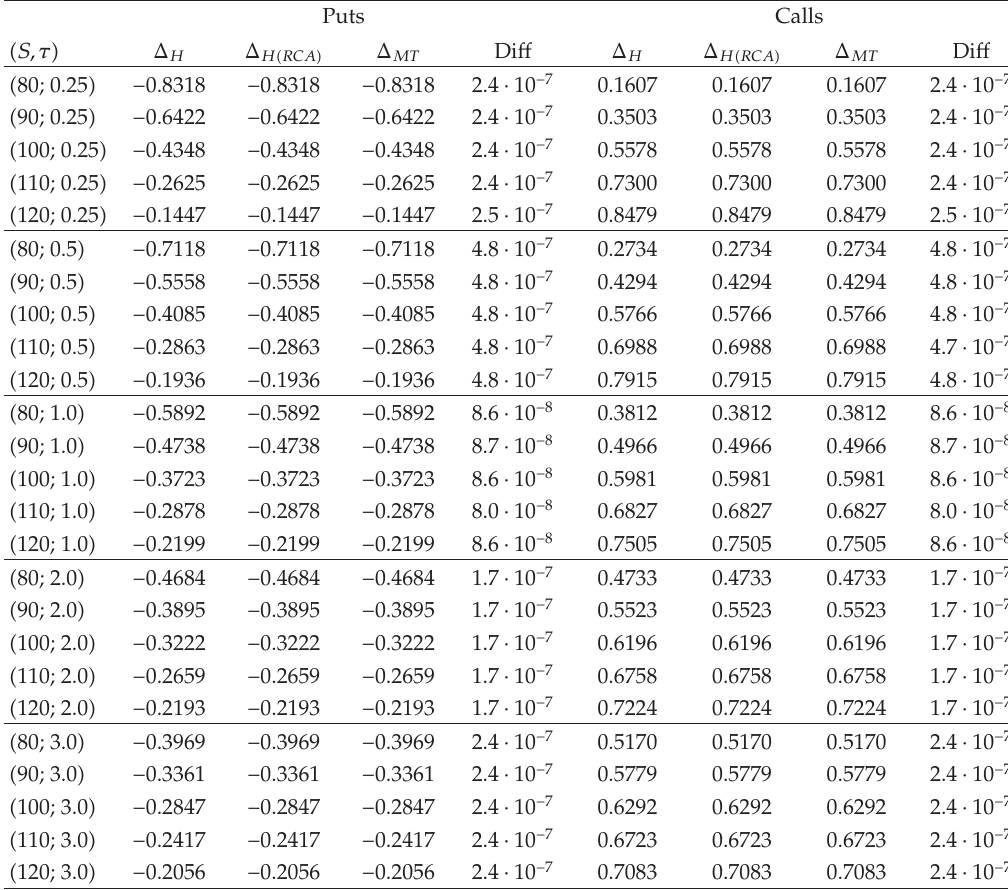
Table 3: Delta values of European option prices in Heston’s stochastic volatility model for di ff erent asset prices S and maturities τ . Fixed parameters are X (cid:8) 100, r (cid:8) 0 . 06, q (cid:8) 0 . 03, V (cid:8) 0 . 16, κ (cid:8) 3, θ (cid:8) 0 . 16, ξ (cid:8) 0 . 1, ρ (cid:8) − 0 . 75, and c (cid:8)